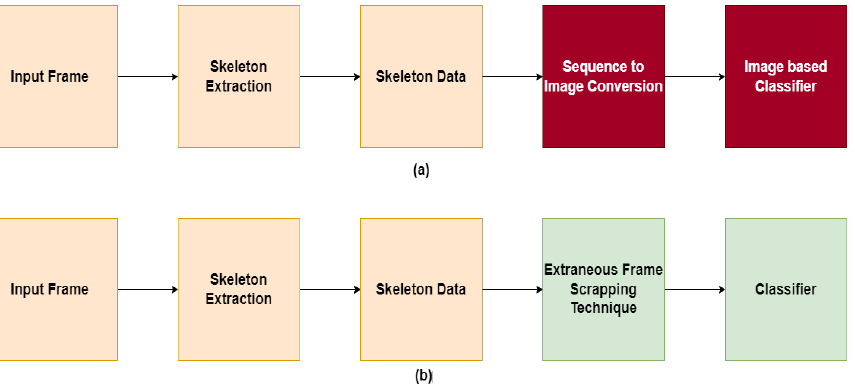
Figure 2. Skeleton-based approaches in HAR. ( a ) Existing method ( b ) Proposed